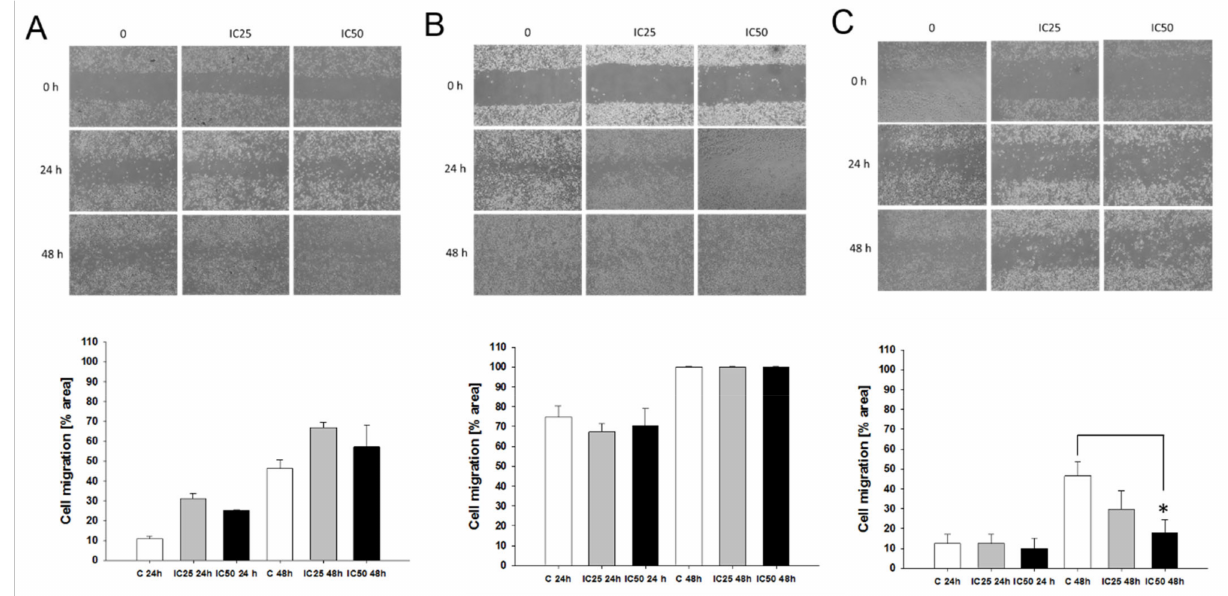
Figure 14. Effect of piperine on the migration of the W1PR1 ( A ), W1PR2 ( B ), and W1TR ( C ) cells. Cell monolayers were scratched with a pipette tip and pretreated with control C and piperine in IC25 and IC50 concentration for 24 h and 48 h. Migrating cells were visualized and photographed by phase-contrast microscopy. The experiments were performed in triplicate. Bars represent the mean of cell migration ± SD values. * p <